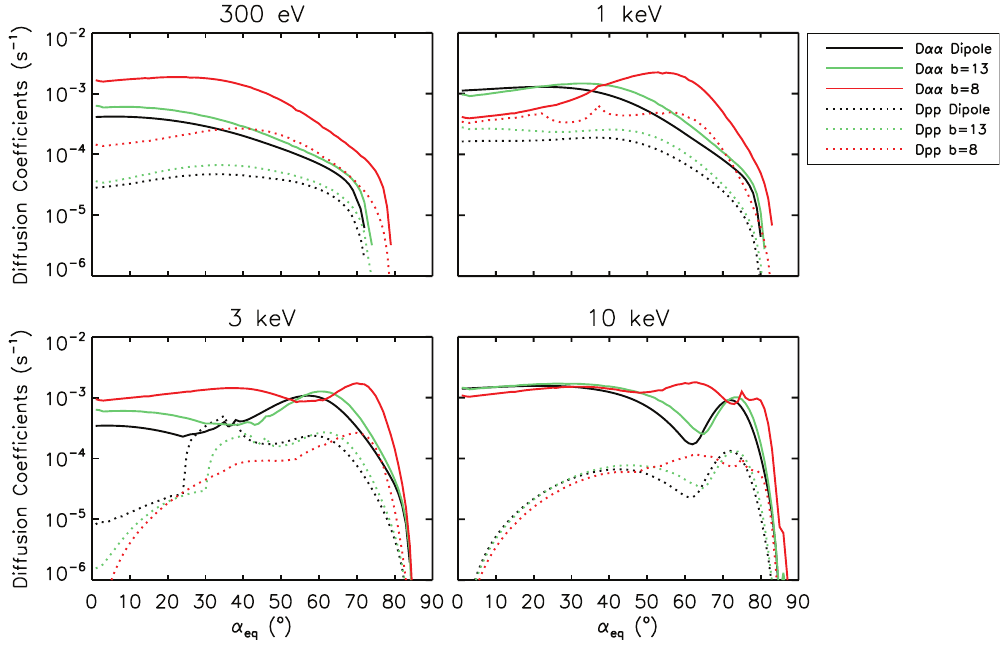
Fig. 3. Bounce-averaged pitch angle diffusion coefficients (solid curves) and energy diffusion coefficients (dotted curves) obtained using Dungey magnetic field models with b = ∞ (black), 13 (green) and 8 (red) at L = 6 and MLT=00:00 for four fixed electron energies of 300eV, 1keV, 3keV, and